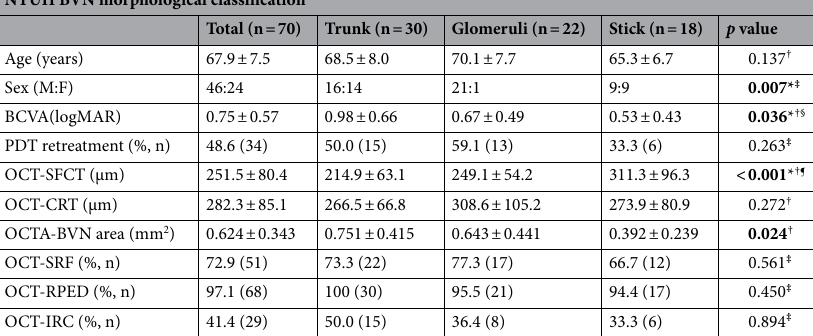
Table 1. Baseline demographic data and clinical features of PCV patients according to the BVN morphologic classification system. Abbreviations: M male, F female, BCVA best-corrected visual acuity, PDT photodynamic therapy, SFCT subfoveal choroidal thickness, CRT central retinal thickness, SRF subretinal fluid, RPED retinal pigment epithelial detachment, IRC intraretinal cyst, PCV polypoidal choroidal vasculopathy, BVN branching vascular network, NTUH National Taiwan University Hospital, OCT optical coherence tomography. Bold values indicate p < 0.05 and were considered significant. † One-way analysis of variance and Bonferroni test for post hoc evaluation if p < 0.05. ‡ Chi-square or Fisher’s exact test. § Post hoc test: p = 0.042, between types 1 and 3 and post hoc test: p = 0.034, between types 1 and 2. ¶ Post hoc test: p = 0.009, between types 1 and